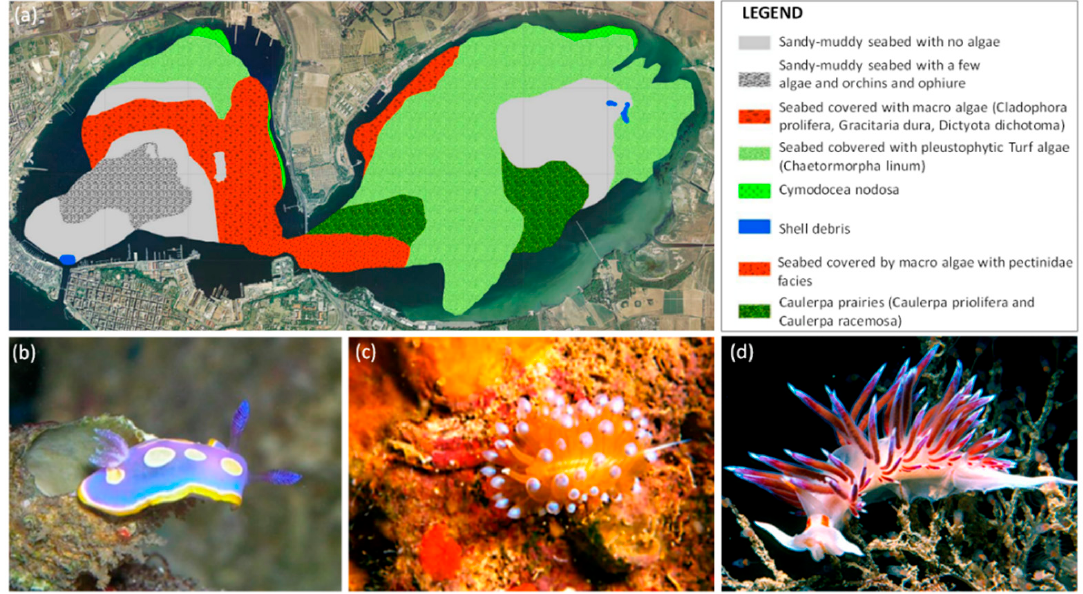
Figure 11. ( a ) Biocenotic map, ( b ) Chromodoris luteorosea, ( c ) Janolus cristatus, ( d ) Cratena Peregrina [31] .